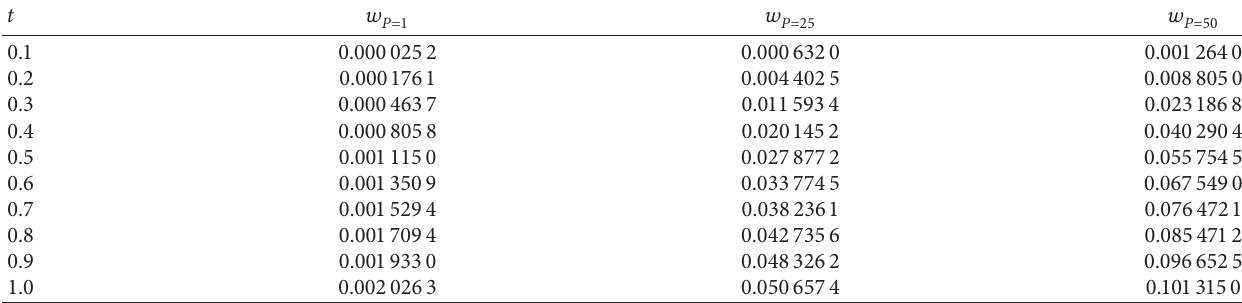
Table 1: Some values of w ( t, x ) for P � 1 , 25 , 50 (for a polybutadiene beam).